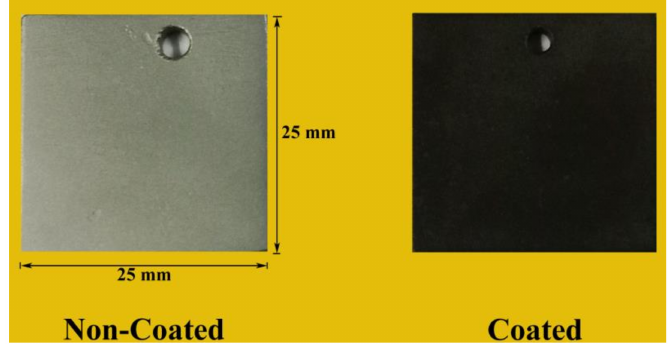
Figure 1. Non-coated and coated stainless steel 420A